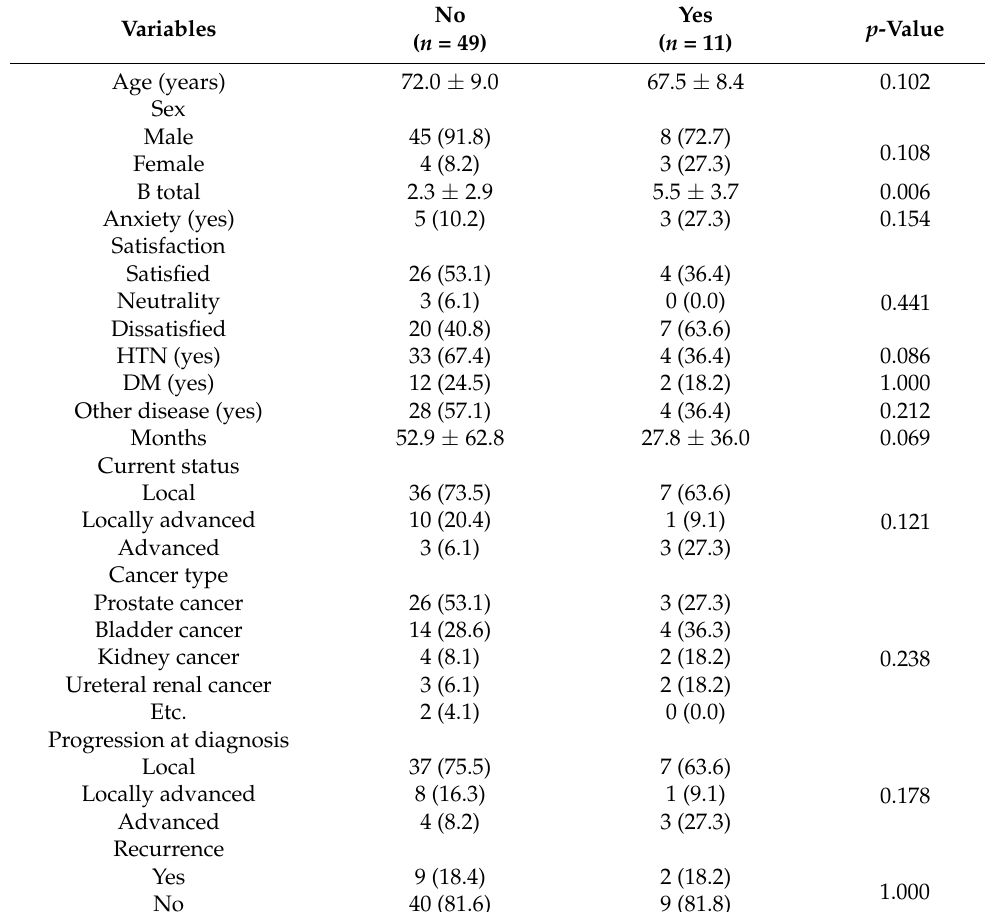
Table 1. General patient